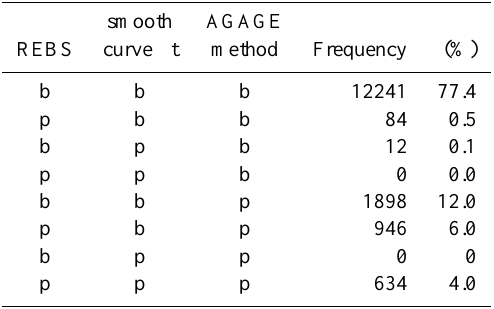
Table 3. Contingency table of the classification of HFC-152a mea- surements at Mace Head from 1995 to 2009 ( n = 28694) with the REBS technique, the smooth curve fit, and the AGAGE method (b=background;